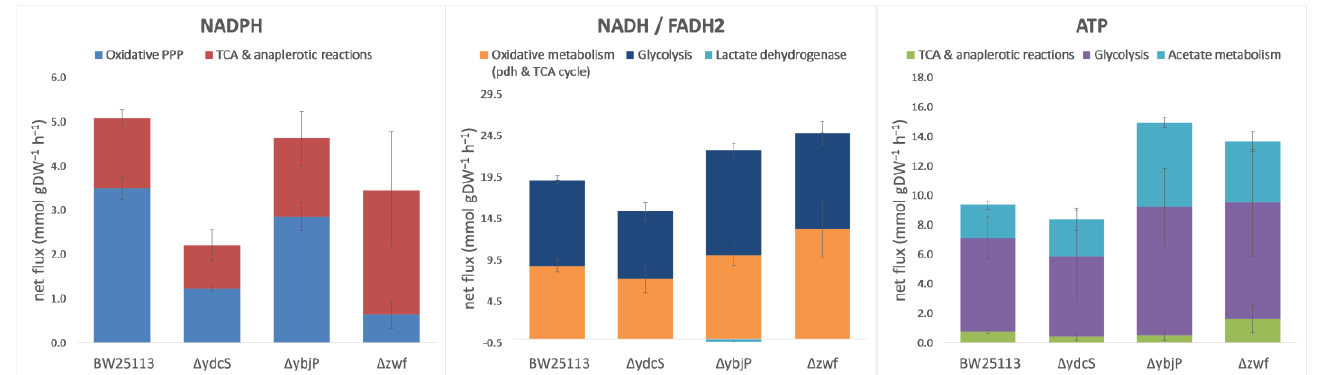
Figure 5. Production of NADPH, NADH/FADH 2 and ATP in the central carbon metabolism. The rates were calculated from the mean growth rates and flux distributions, and are expressed in absolute values (mmol.gDW −1 ·h −1 ) ± SD. Calculations are described in the materials and methods.